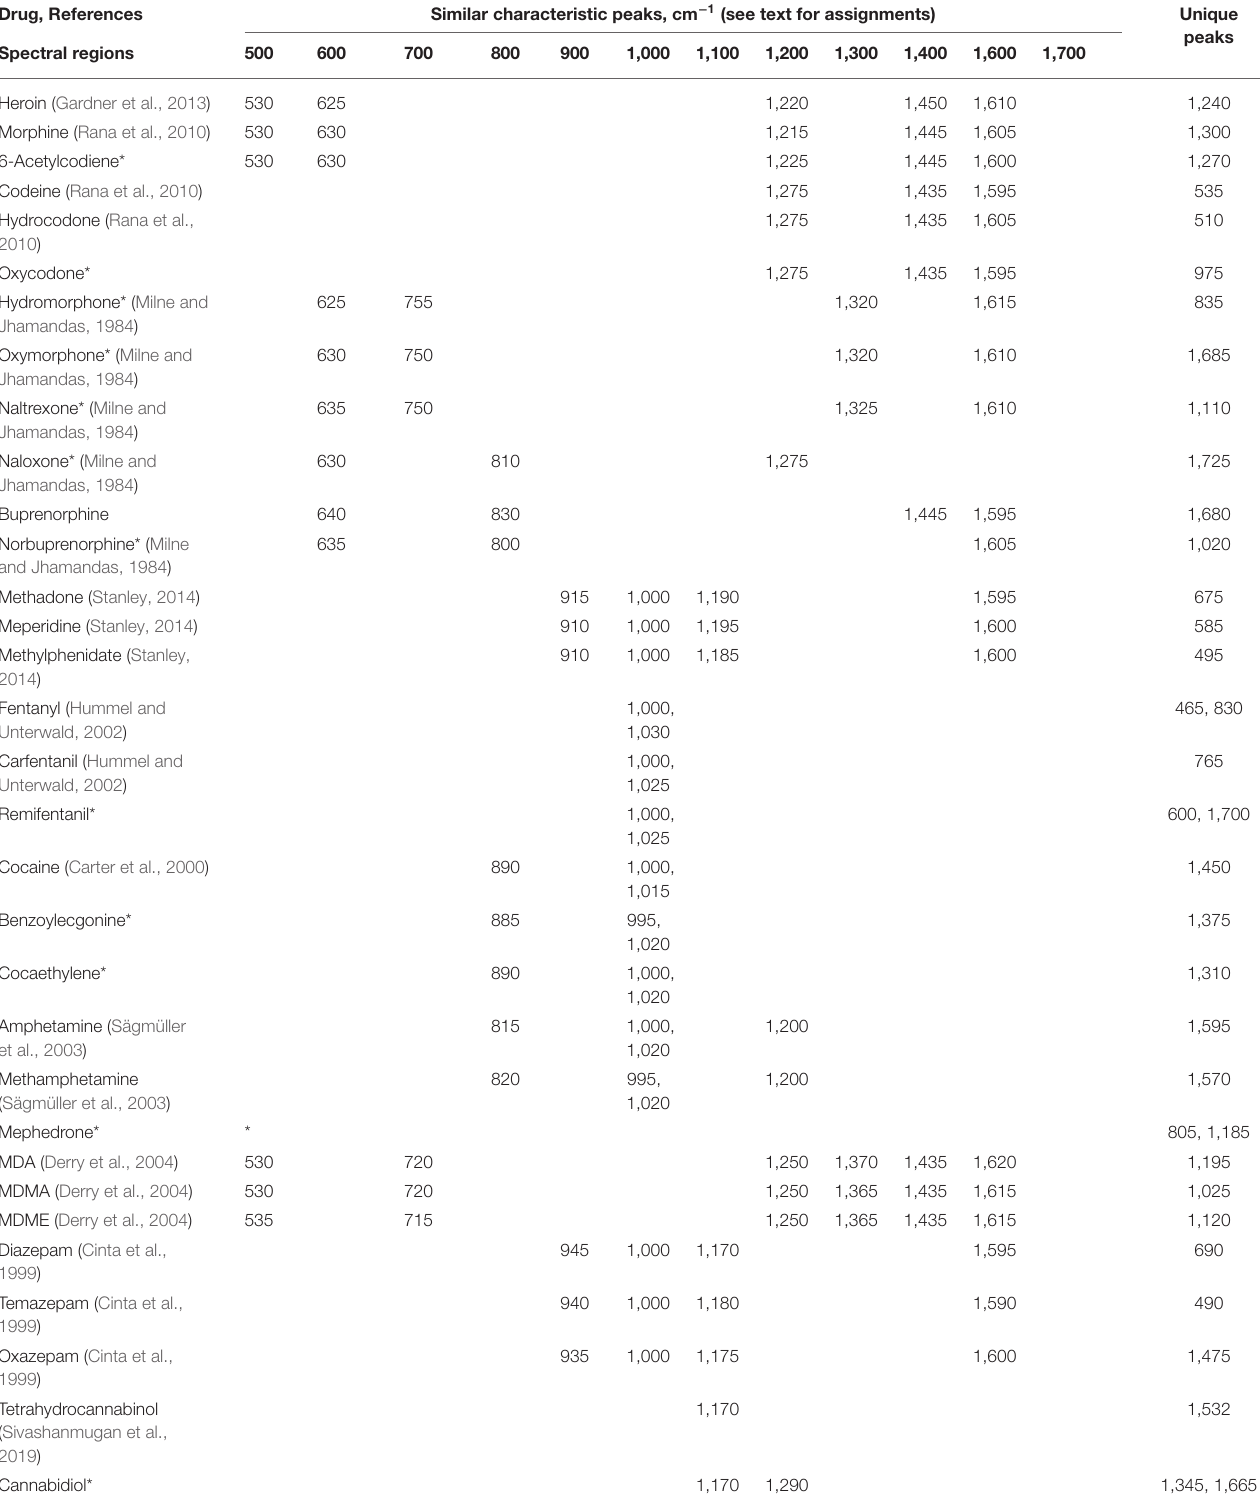
TABLE 1 | Similar characteristic and unique SERS peaks for the 39 drugs measured using gold colloids and 785nm excitation (see text for assignments). Drug, References Similar characteristic peaks, cm − 1 (see text for assignments) Unique